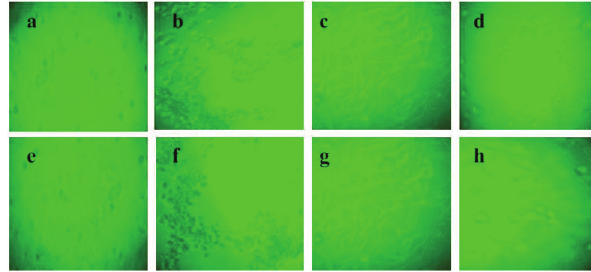
Figure 16: Micrograph of cytotoxicity induced by Ag NPs on Vero and HEp2 cells. Vero: control (a,e), IC50 of A. bilimbi Ag NPs (b) and IC50 of Plum Ag NPs (f). HEp2: control (c,g), IC50 of A. bilimbi Agnps (d) and IC50 of Plum Ag NPs